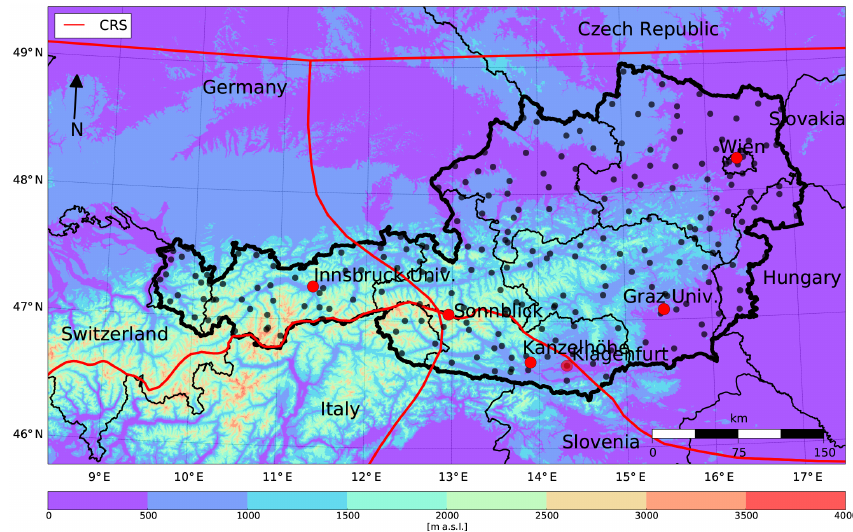
Figure 1. Topographic map (color-coded elevations) with ARAD stations (red points; the station at Klagenfurt is planned to start operating in 2016), TAWES stations measuring GLO (black points) and the coarse resolution subregions (CRSs) defined as regions with common climatic variability (see